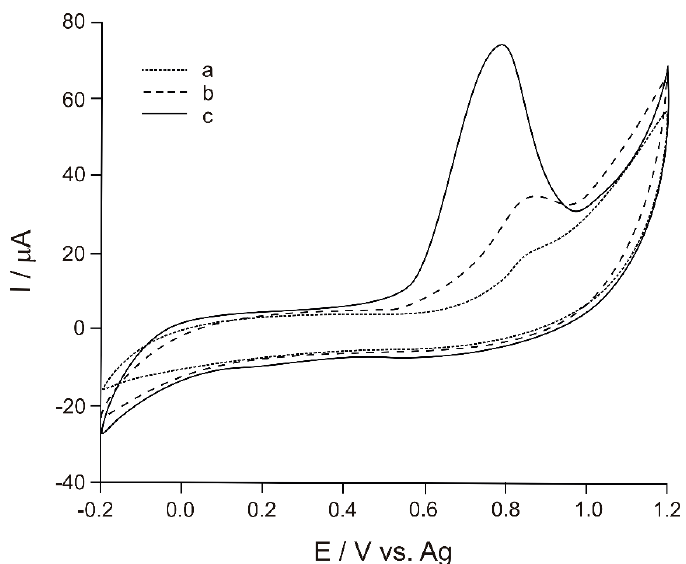
Figure 2. Cyclic voltammograms (CVs) of CSPE (curve a), PtNP/GPH/Chit–carbon screen-printed electrode (CSPE) (curve b), Ty/PtNP/GPH/Chit–CSPE (curve c) immersed in 10 − 4 Tyr, PBS 0.1M, pH = 7.